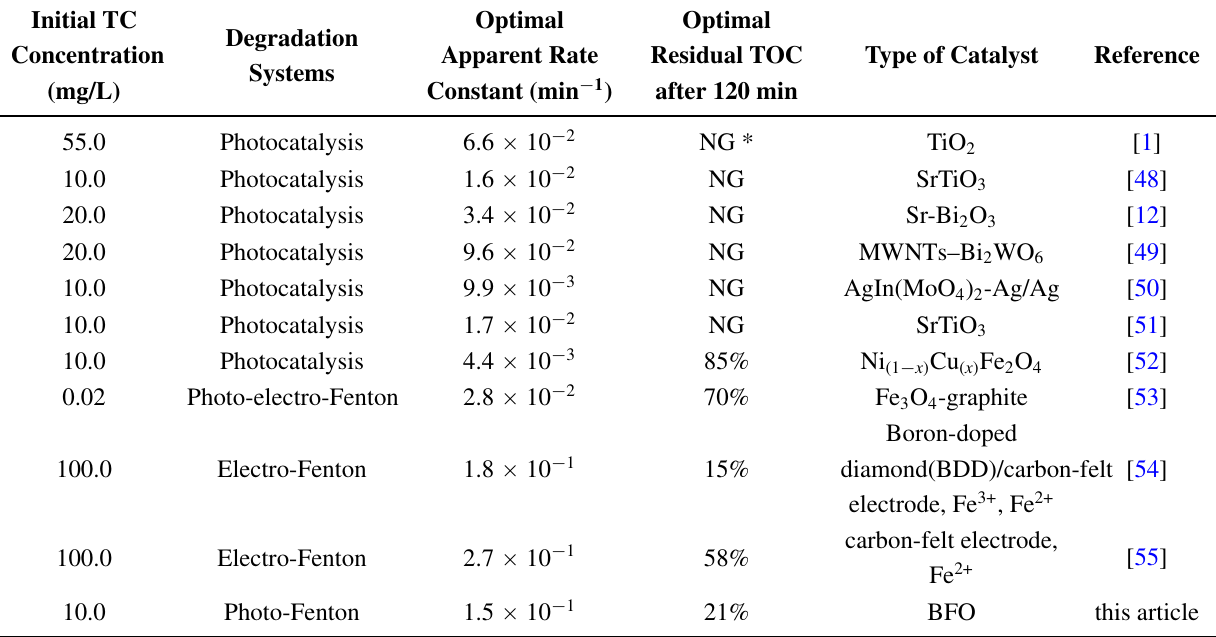
Table 2. Comparison of different advanced oxidation processes (AOPs) for removing